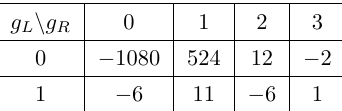
) = (1 , 1) in the B , d E